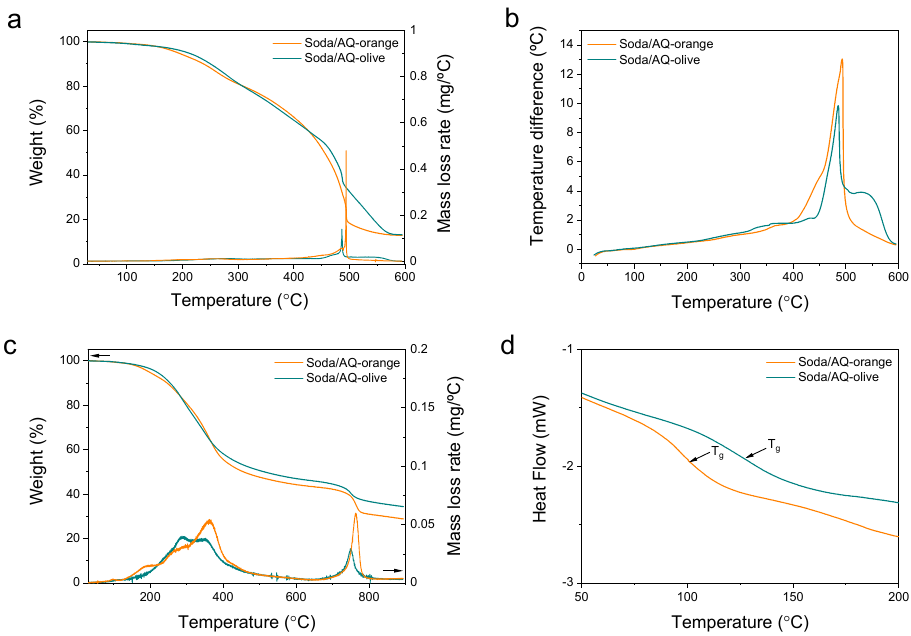
Figure 8. Thermogravimetry (TG) curves in air ( a ) and in nitrogen ( c ) and differential thermal analysis (DTA) curves in air ( b ) of orange and olive soda/AQ lignins. Differential scanning analysis (DSC) curves in nitrogen ( d ). The glass transitions (T g ) are indicated by arrows.